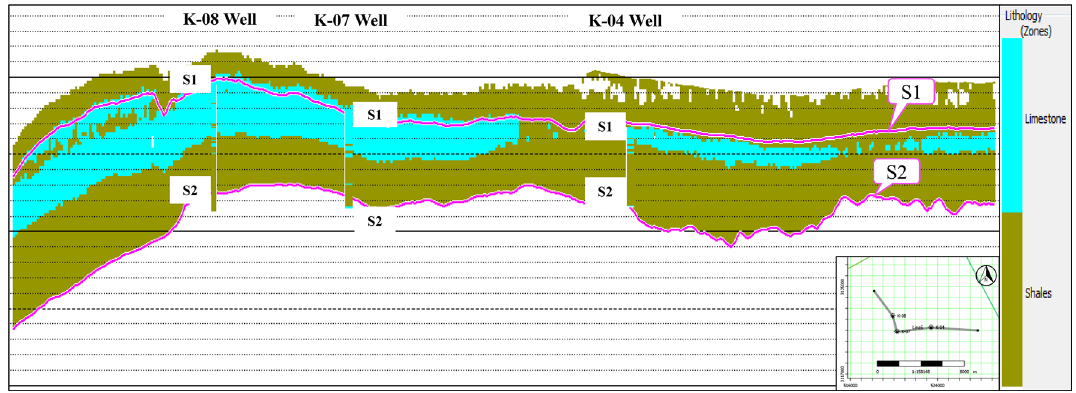
Fig. 19 Litho-facies (tight limestone and shale) cross section along the three